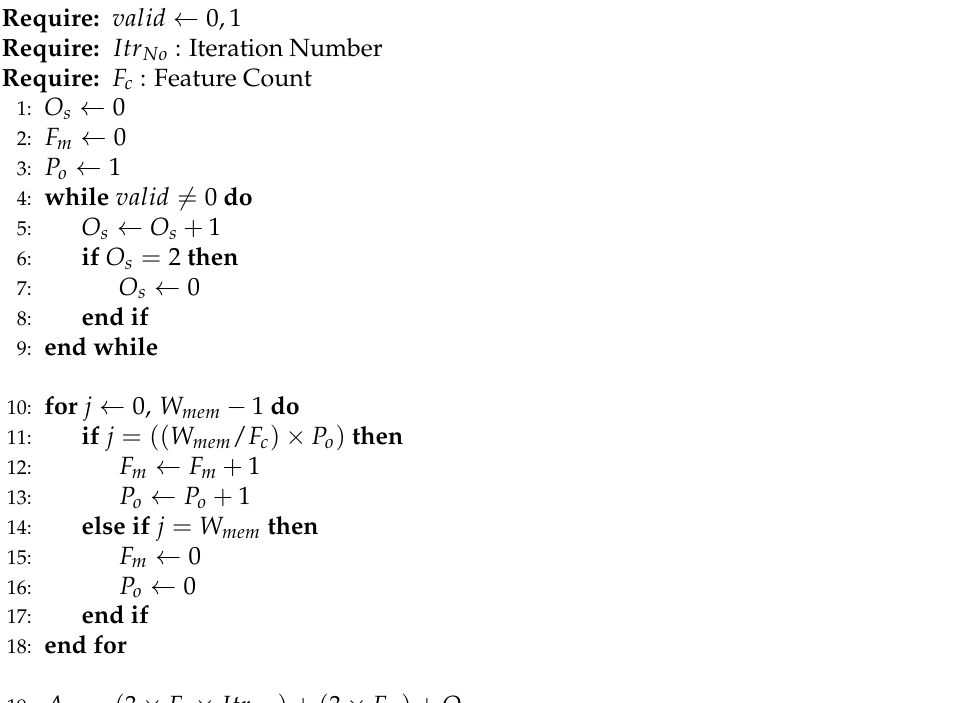
Algorithm 2 AGU for input weights